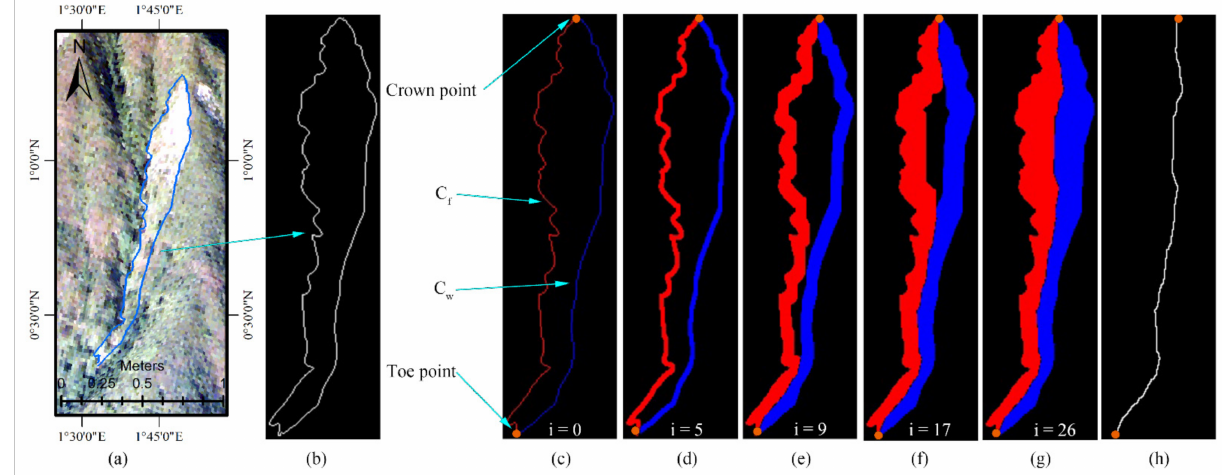
Figure 6. Example of landslide trail extraction with the proposed LTE method from a real-word landslide polygon. ( a ) Landslide in 3-D view aerial photo; ( b ) landslide polygon in 2-D plane; ( c – g ) the FEM process, where i indicates the ith iteration; ( h ) the resulting landslide trail.